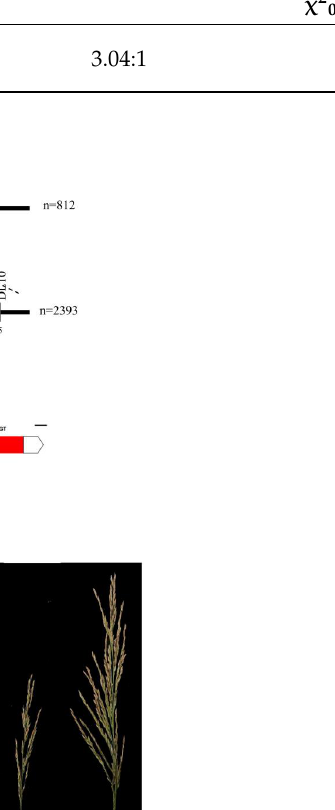
Table 1. Segregate pattern of the F 2 population from the cross of CHA-1 and 02428. Types